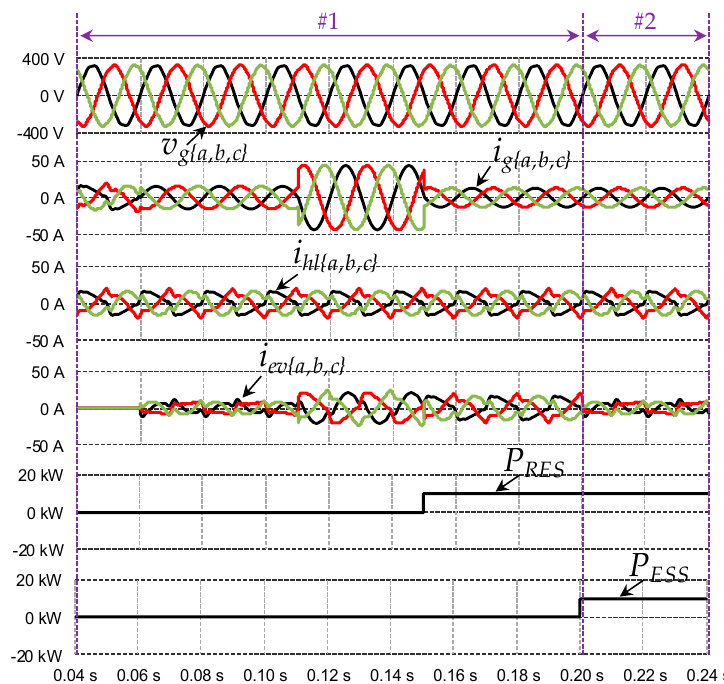
Figure 20. Principle of operation representative of the off-board EVBC: Unified operation of power quality compensator, renewables and energy storage systems.